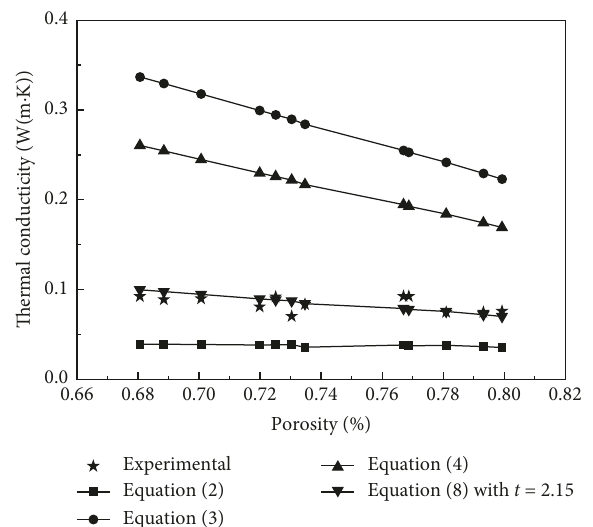
Figure 7: Comparison between the theoretical and experimental results.